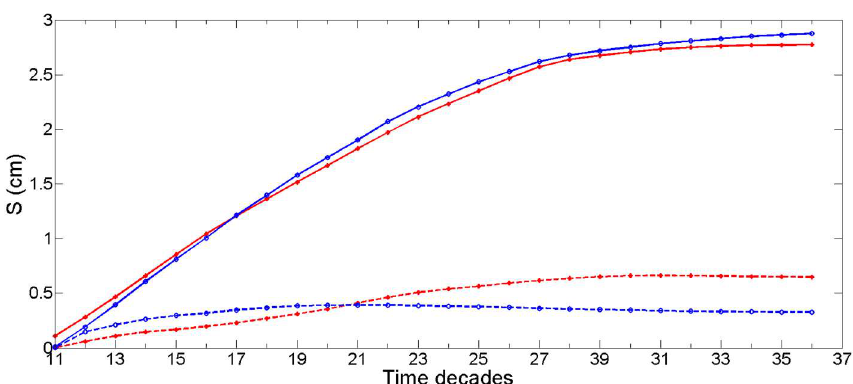
Figure 8. Comparison of average (solid lines) and standard deviation (dashed lines) of shell length from Gamma process (blue lines) and DEB model (red lines). Time unit represents 10 day periods.